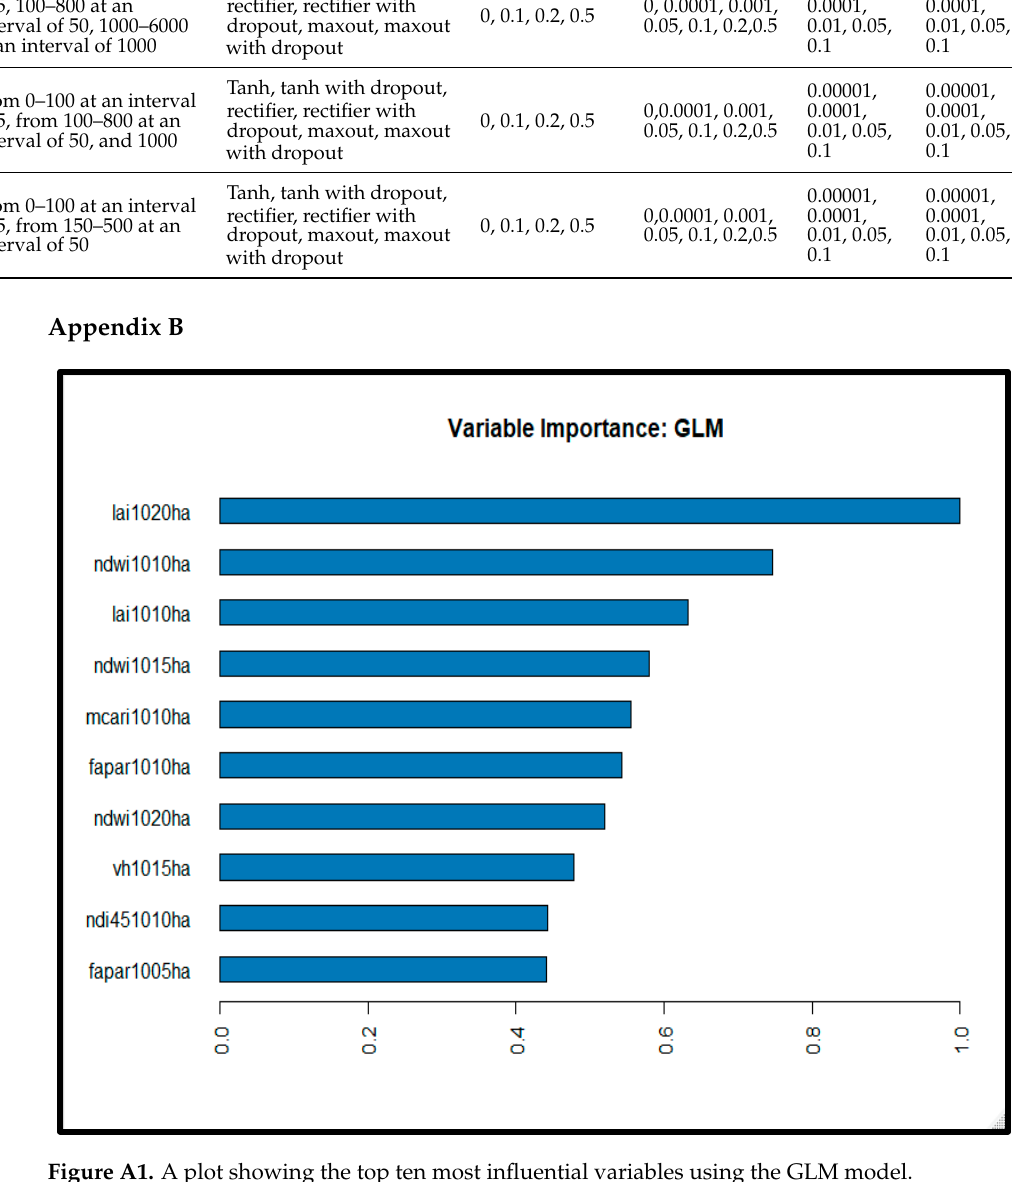
Figure A1. A plot showing the top ten most influential variables using the GLM model.